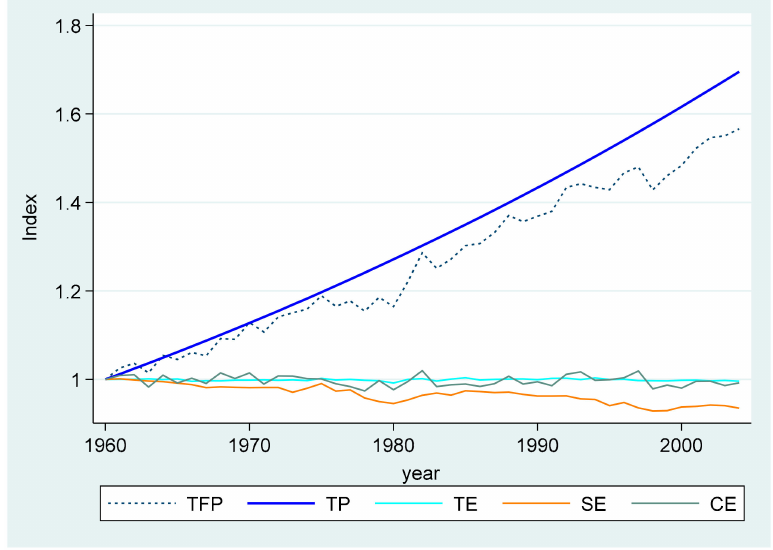
Figure 4. Evolution of TFP drivers,